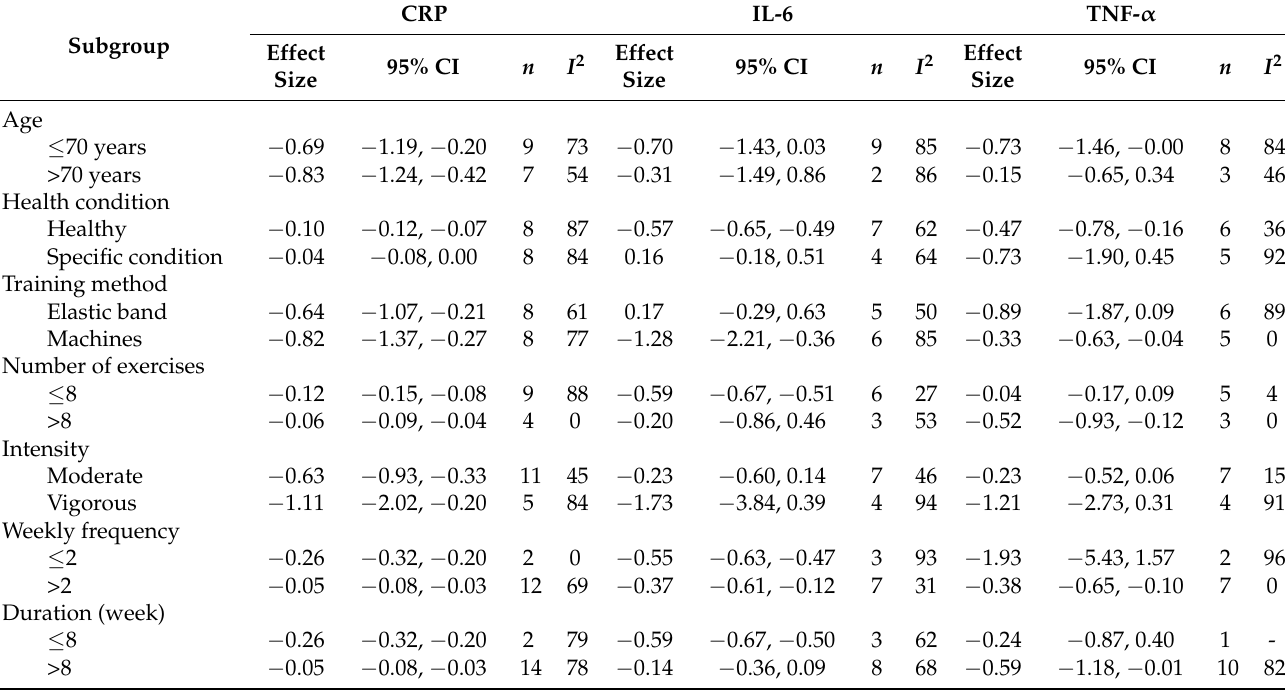
Table 2. Subgroup analysis of the effects of RT of elderly